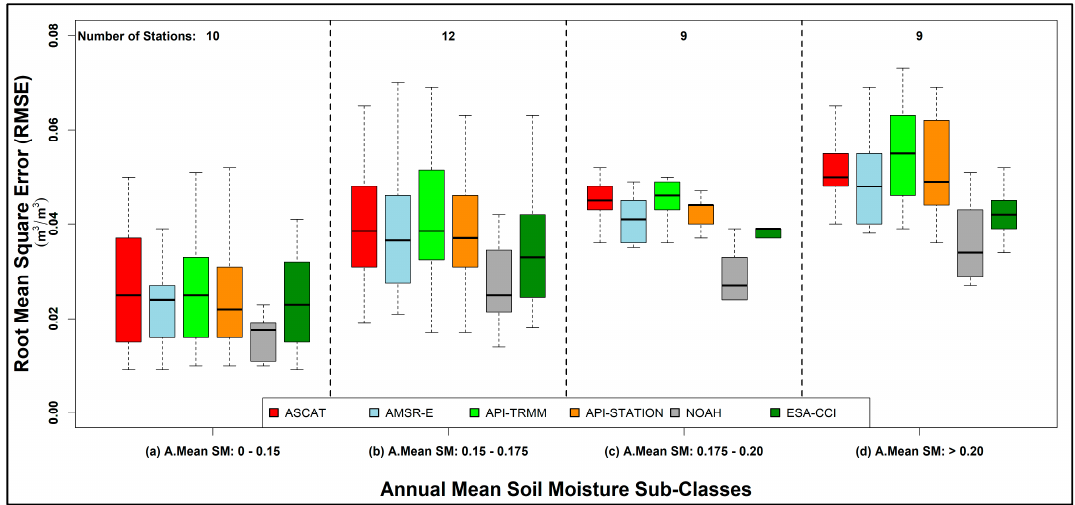
Figure 9. RMSE of soil moisture products under annual mean soil moisture sub-classes.